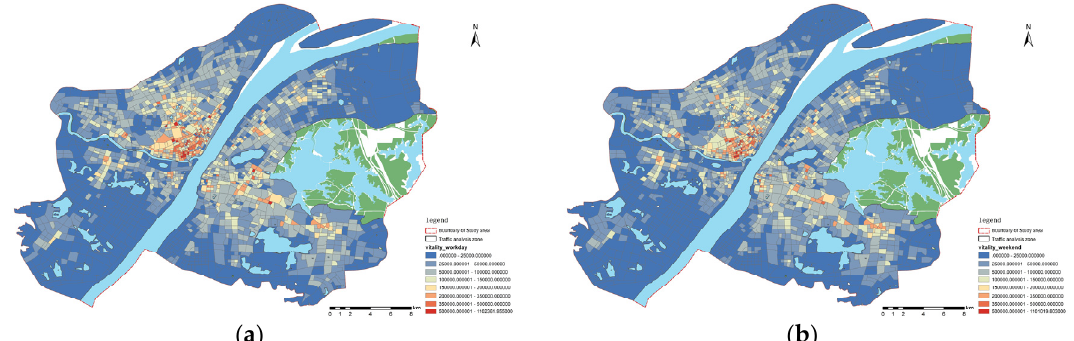
Fig18 Figure 18. Comparison of the spatial distribution of block vitality. ( a ) Workday block vitality distribution; ( b ) weekend block vitality